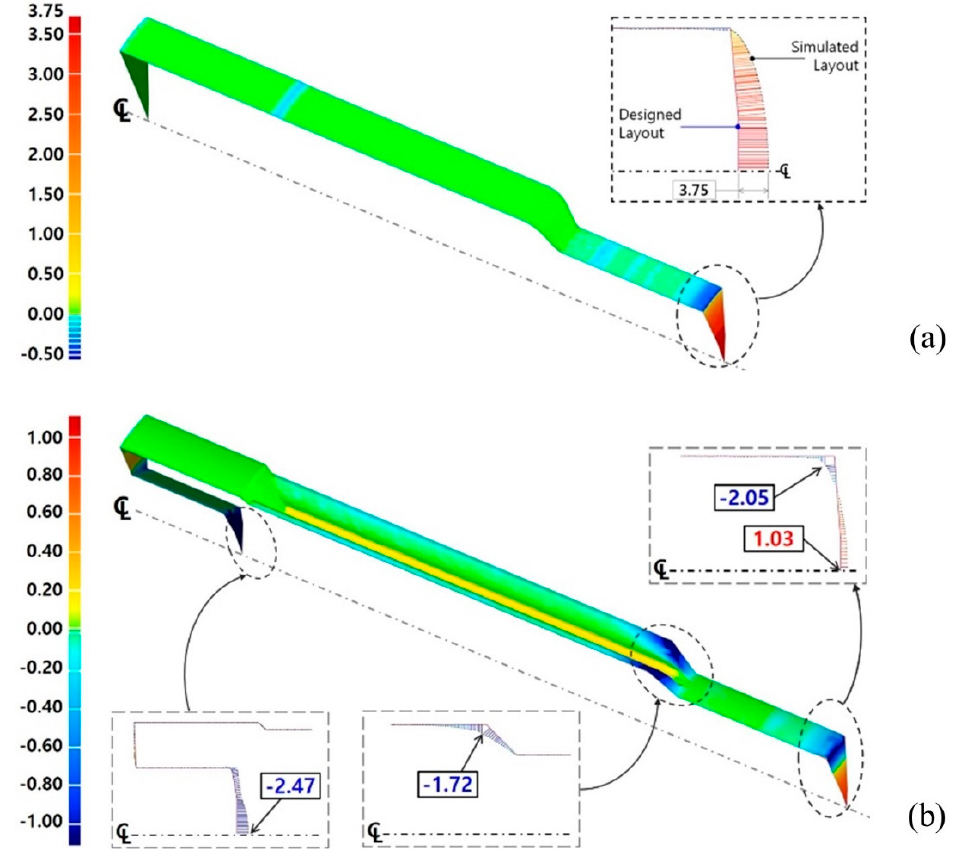
Figure 13. Comparisons of dimensional relevancy between the designed and simulated results (unit: mm): ( a ) relative dimensional error between the simulated and designed preform with a θ 1 = 45°; ( b ) relative dimensional error between the simulated and designed drive shaft with a θ 1 = 45° and a θ 2 = 45°.